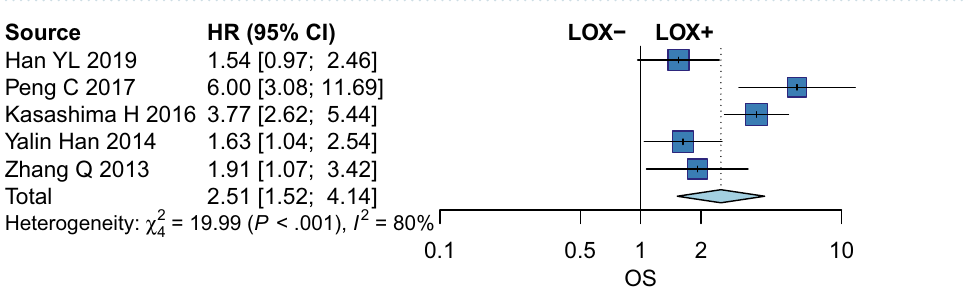
Figure 3. Funnel plot for the relationship between LOX expression and clinicopathological characteristics: gender ( a ), Lauren classification ( b ), differentiation ( c ), depth of invasion ( d ), lymph node metastasis ( e ) and tumor distant metastasis ( f ).